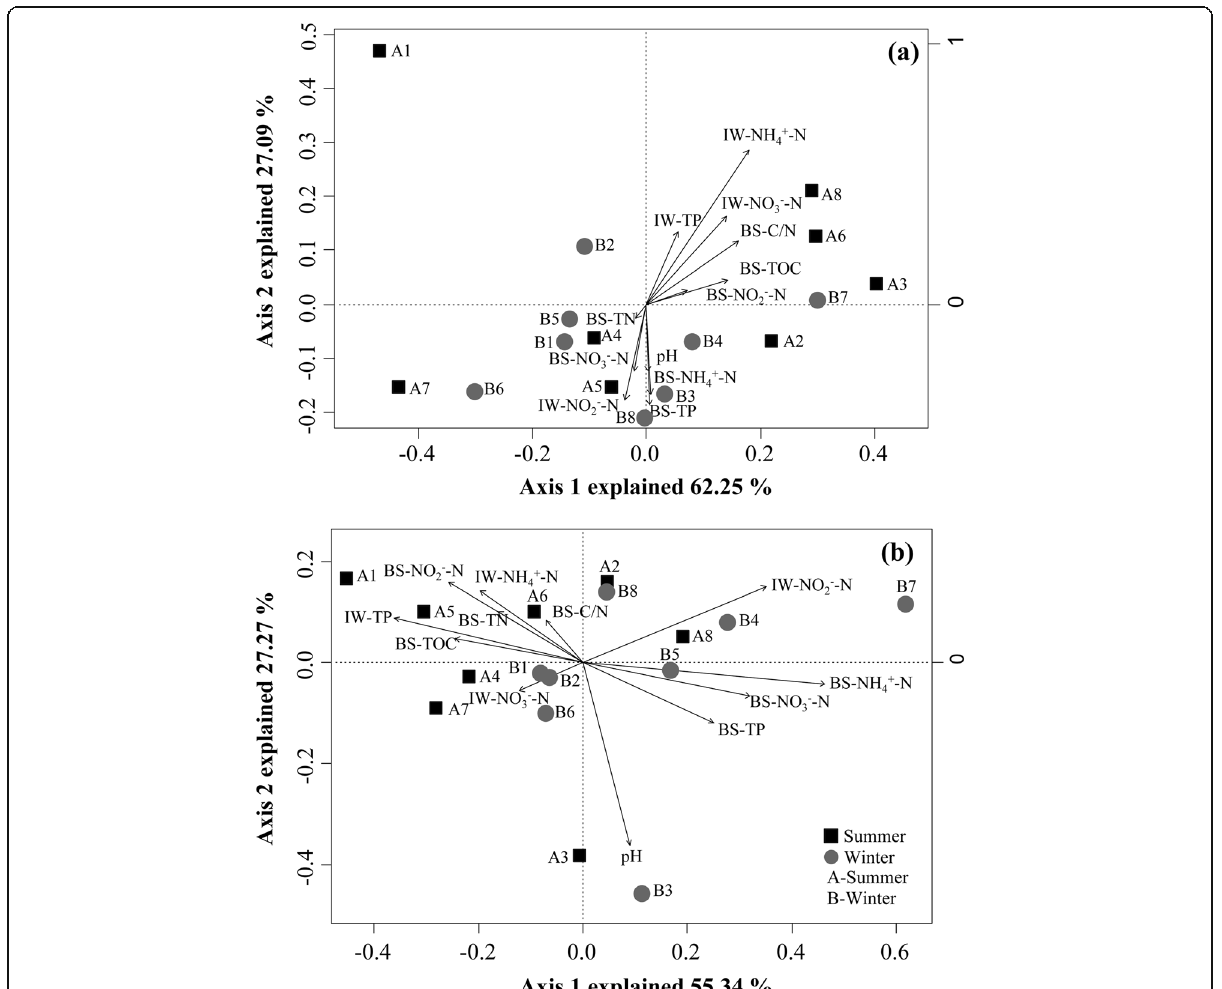
Fig. 7 Redundancy analyses (RDA) of 16S rRNA ( a ) and nutrient variables in summer and winter. Redundancy analyses (RDA) of pmoA genes ( b ) and nutrient variables in summer and winter. Correlations between environmental factors and RDA axes are represented by the length and angle of arrows . T, temperature; NO 2 — N, nitrite; NO 3 — N, nitrate; NH 4+ -N, ammonium; TP, total phosphorus; TN, total nitrogen; TOC, total organic carbon; C/N, total organic carbon/total nitrogen; IW, interstitial water; BS, bottom sediment; A, summer; B,